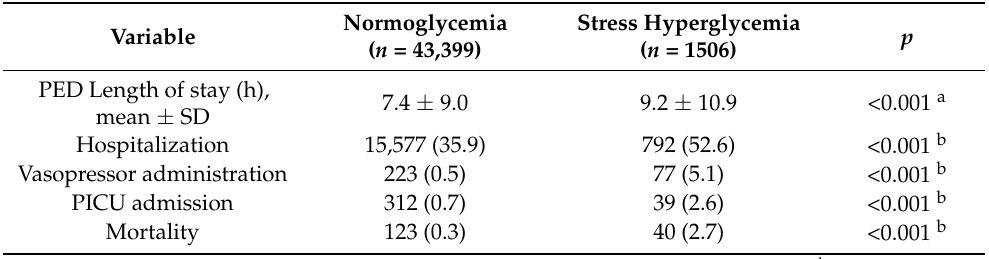
Table 2. Comparison of outcomes for patients with stress hyperglycemia and normoglycemia ( n =